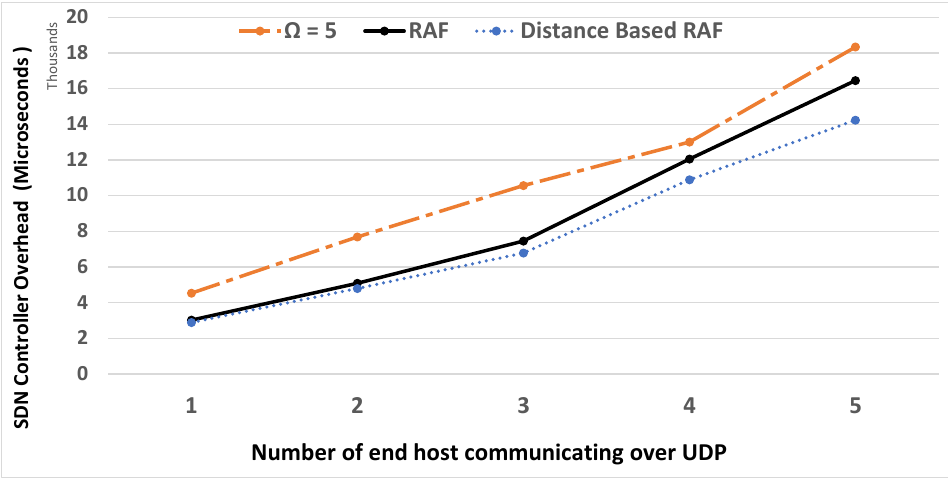
Figure 3. Controller overhead for path computation.